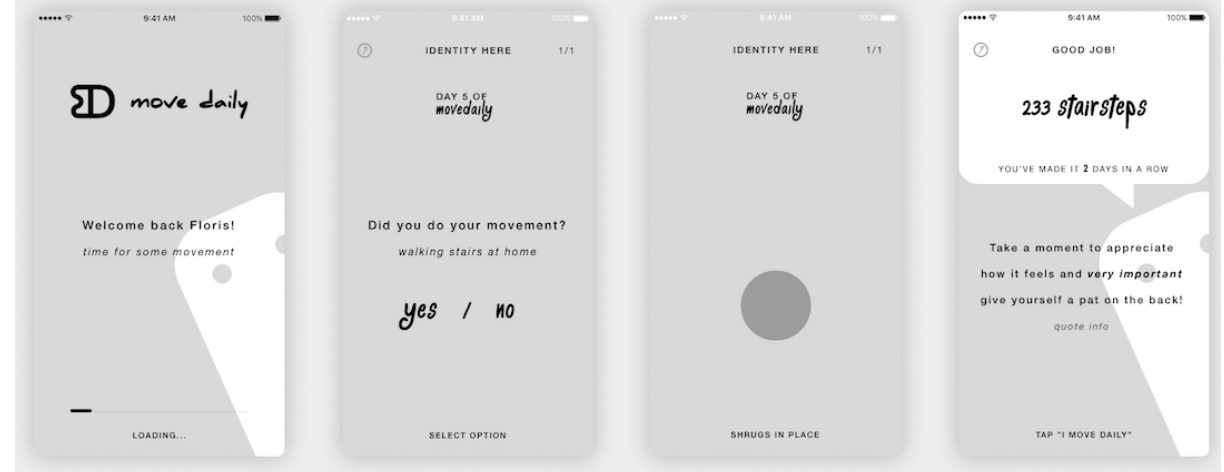
Figure 7. Selection of wireframes informing the final design of the mobile app